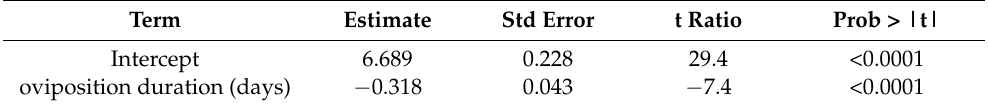
Table 4. Parameter estimates, standard error and significance level (t ratio and p -value) for a multiple linear regression model of mean hatching time (days) for experiment